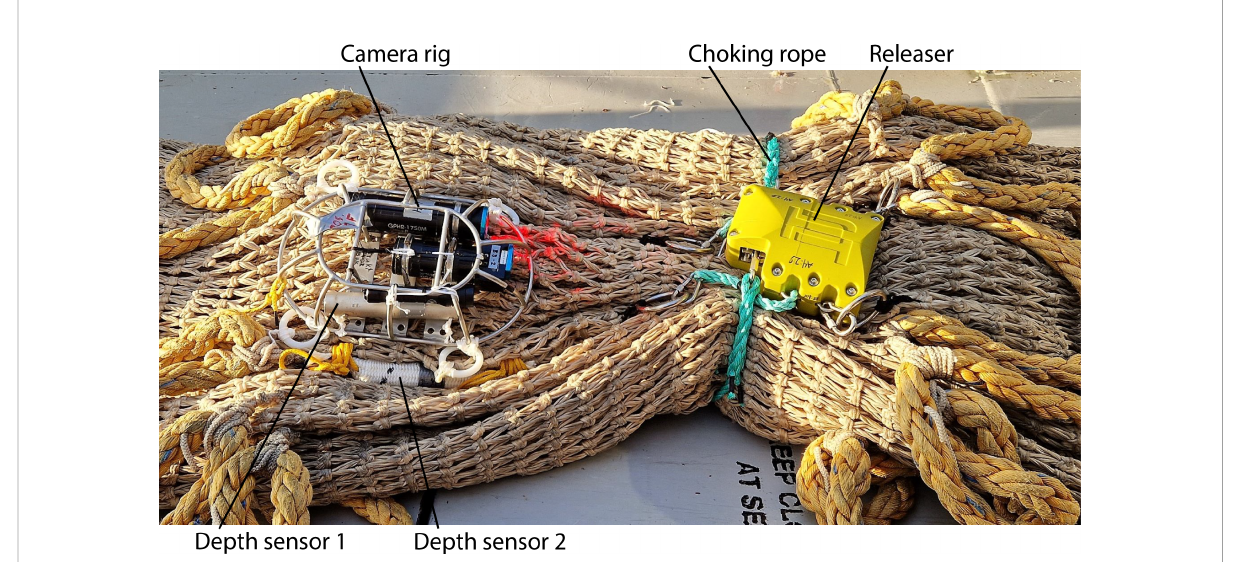
FIGURE 4 Depth triggered releaser mounted on codend with a choking rope. Camera in a steel frame facing towards the catch release